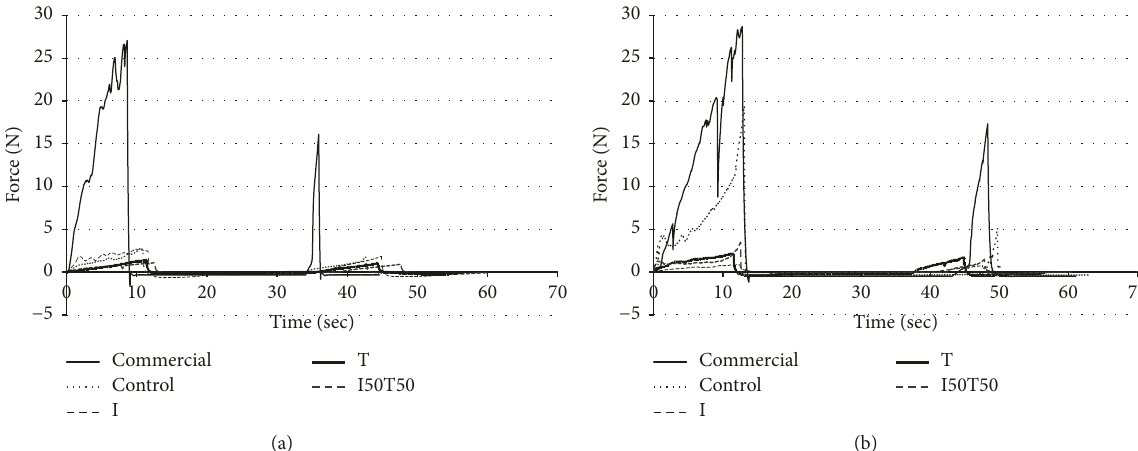
Figure 1: Representative curves of TPA test for watermelon jelly studied as a function of sweeteners used in its formulation, initially (a) and after 15 days of storage